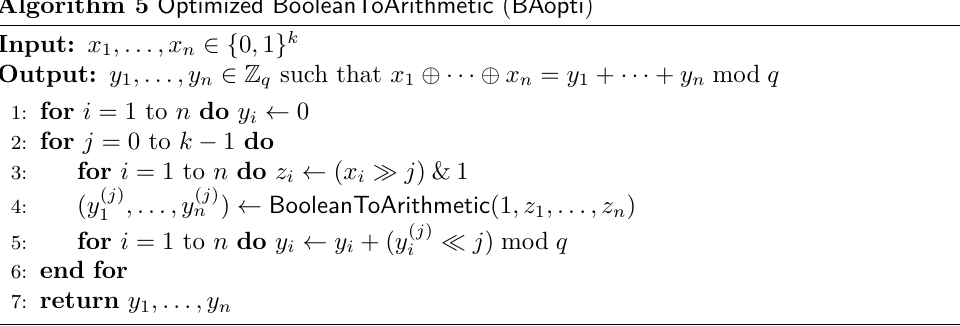
Algorithm 5 Optimized BooleanToArithmetic ( BAopti